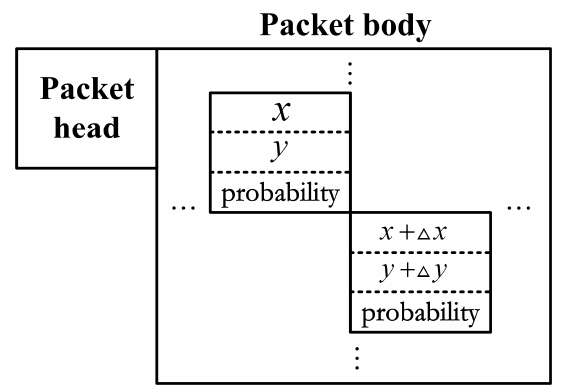
Figure 3 . Packet format for target location